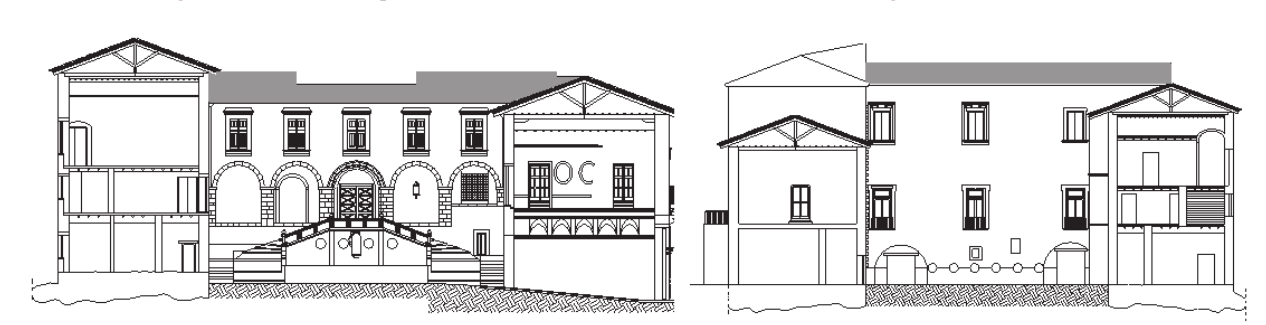
Figure 6: Ground floor plan. Figure 7: Elevation.